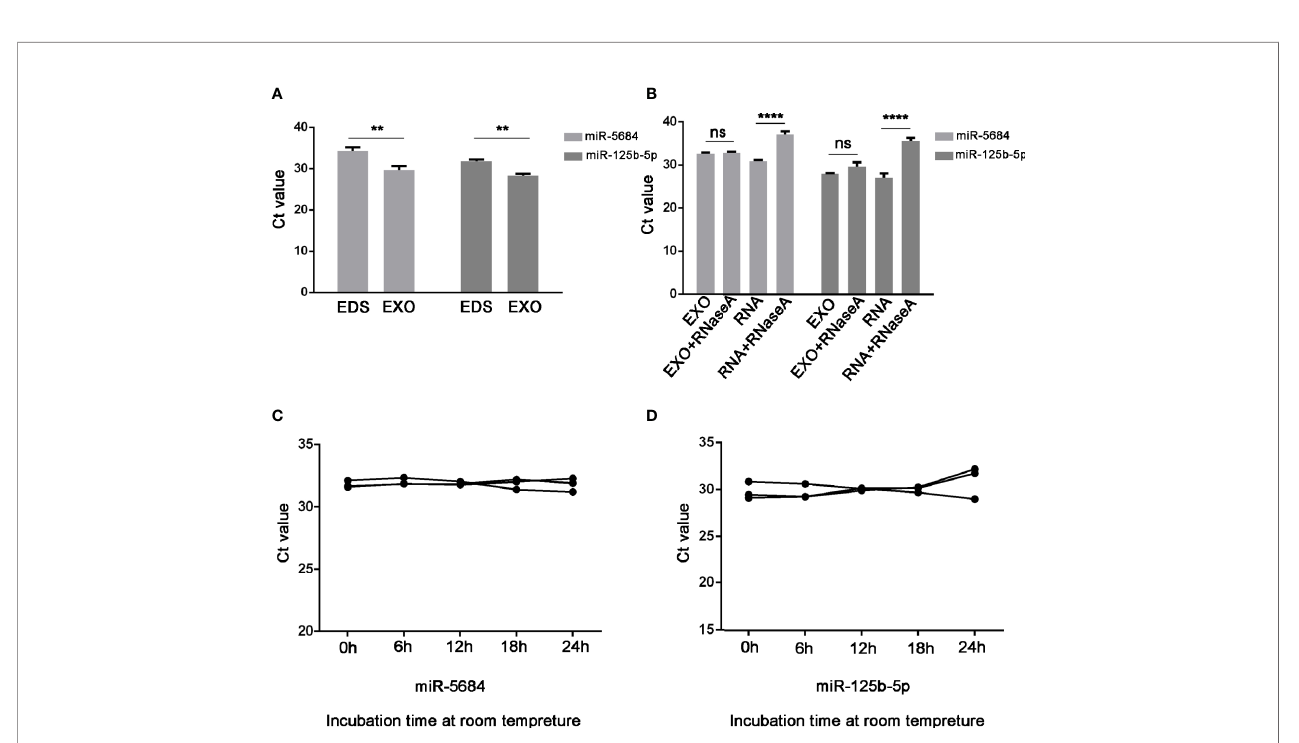
FIGURE 4 | Characteristics of serum exosomal miR-5684 and miR-125b-5p. (A) Expression levels of miR-5684 and miR-125b-5p from serum exosomes (EXO) and exosome-depleted supernatant (EDS). (B) Expression levels of both miRNAs in exosomes treated with RNase A or in isolated RNA. (C, D) Expression levels of the miRNAs in exosomes incubated at room temperature for different durations (**P < 0.01, ****P < 0.0001, ns, not signi fi